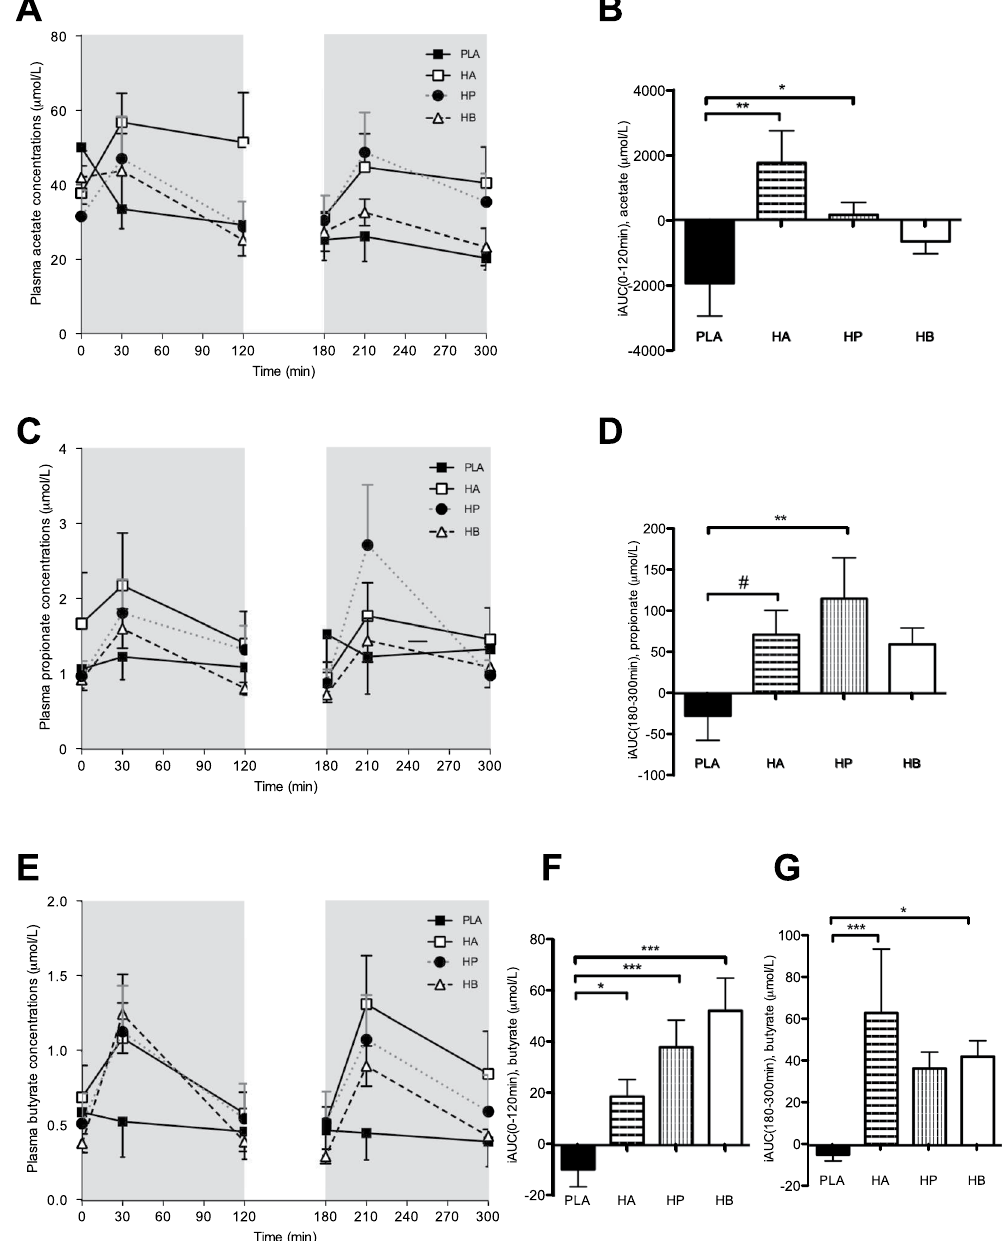
Figure 2. Effect of colonic administration of SCFA mixtures on fasting and postprandial plasma acetate ( A,B ), propionate ( C,D ), and butyrate ( E–G ) concentrations ( A ) Fasting (t0–t120 min) and postprandial (t180– t300 min) plasma acetate concentrations after colonic SCFA infusions. ( B ) iAUC for fasting (t0–t120 min) plasma acetate following colonic SCFA infusions. Overall treatment effect for fasting plasma acetate P = 0.051 (period P = 0.338, carry-over P = 0.898). ( C ) Fasting (t0–t120 min) and postprandial (t180–t300 min) plasma propionate concentrations after colonic SCFA infusions. ( D ) iAUC for postprandial (t180–t300 min) plasma propionate following colonic SCFA infusions. Overall treatment effect for postprandial plasma propionate P = 0.068 (period P = 0.781, carry-over P = 0.896). ( E ) Fasting (t0–t120 min) and postprandial (t180–t300 min) plasma butyrate concentrations after colonic SCFA infusions. ( F ) iAUC for fasting (t0–t120 min) plasma butyrate following colonic SCFA infusions. Overall treatment effect for fasting plasma butyrate P < 0.001 (period P = 0.997, carry-over P = 0.879) ( G ) iAUC for postprandial (t180–t300 min) plasma butyrate following colonic SCFA infusions. Overall treatment effect for postprandial plasma butyrate P = 0.032 (period P = 0.754, carry-over P = 0.971). Values are means ± SEMs (n = 12). Statistical significance indicated as asterisk ( * ) when *** P < 0.001, ** P < 0.01, * P < 0.05 and as hashtag when # P <